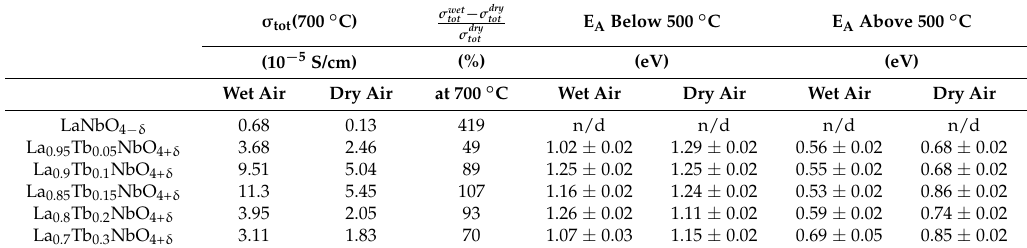
Table 2. Summary of electrical properties of La 1 − x Tb x NbO 4+ δ : total conductivities at 700 ◦ C, a relative difference of total conductivities in wet and dry atmospheres at 700 ◦ C, and apparent activation energies of conductivity in temperature ranges below and above 500 ◦ C. σ tot (700 ◦